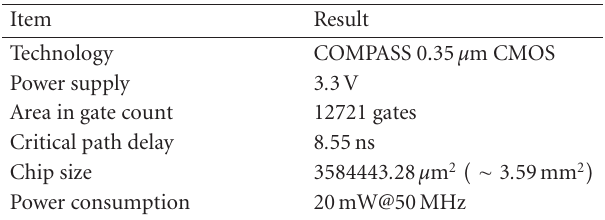
Table 8: The details of the physical implementation on the pro- posed signal security